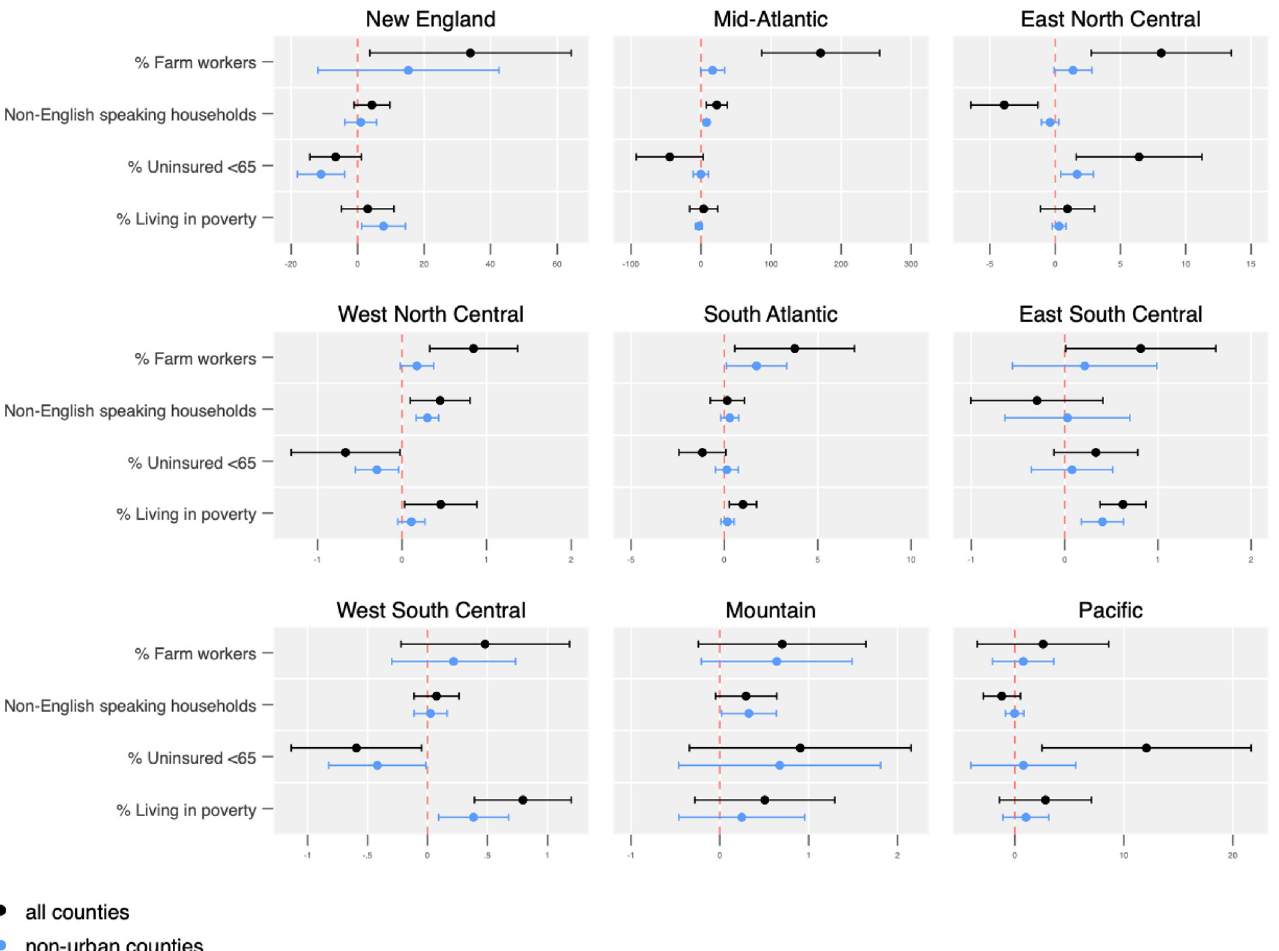
Fig 4. Absolute number of deaths associated with covariates by US census region in all counties and non-urban counties.